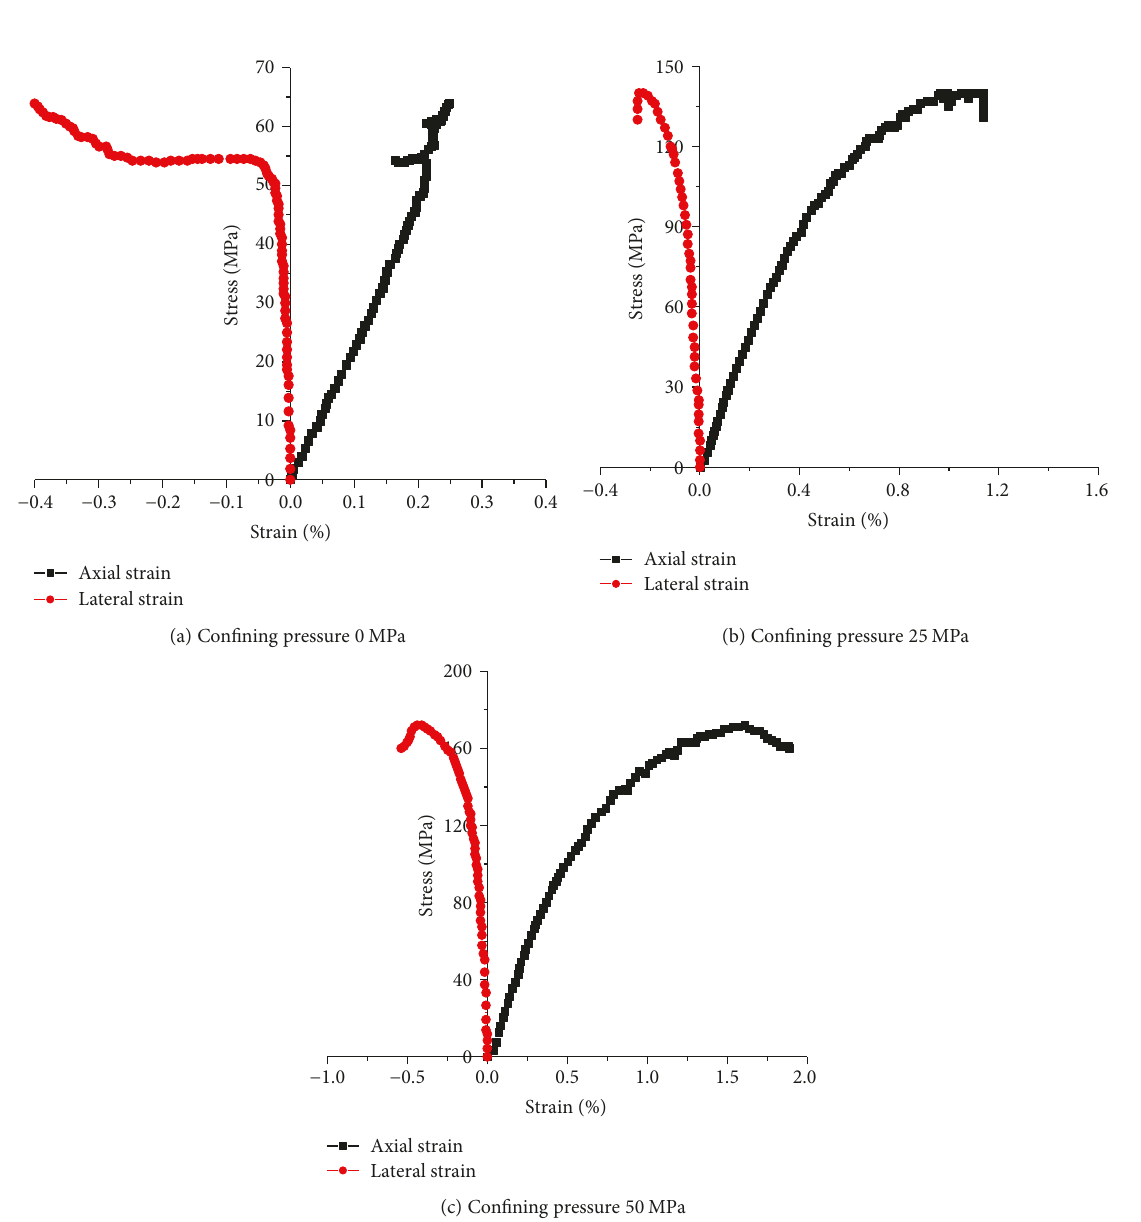
Figure 4: Triaxial test results of original rock in the W-82 well (depth